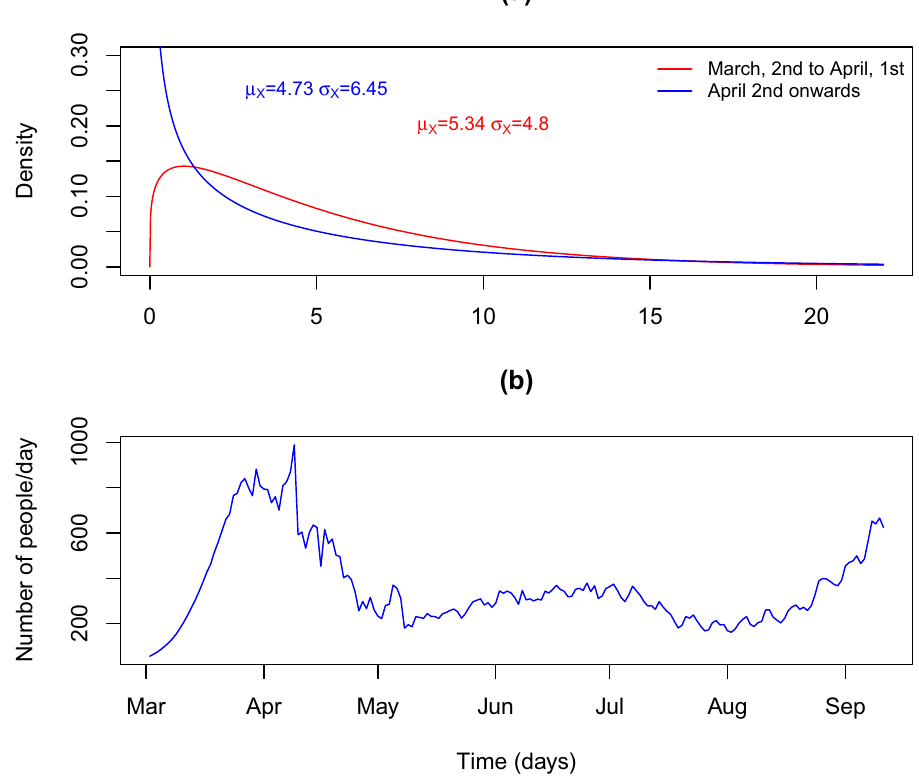
Figure 5. Distribution of time from symptom onset to case confirmation and reporting and the resulting curve of the estimated curve of daily infective people. ( a ) Distribution of time from symptom onset to case confirmation and reporting. ( b ) Estimated infectious ( dEI t ) cases in